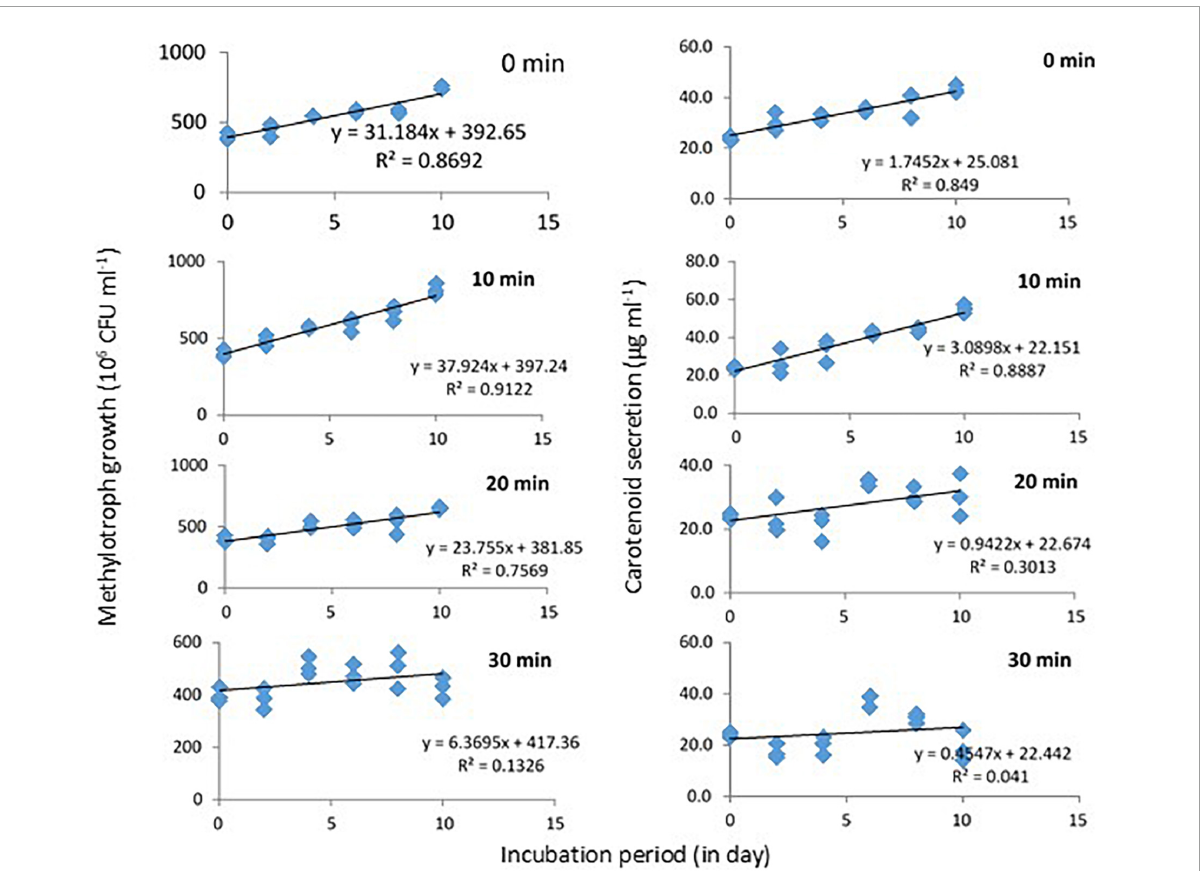
FIGURE4 Growth and carotenoid production by a pink pigmenting Methylobacter sp N39 (Genbank Acc no MW276130.1) in response to UV radiation. The bacterium was cultured in a synthetic medium. Broth was exposed to UV radiation for different timings (0, 10, 20, and 30 min). For each data point, a portion of broth was sampled at 2 days interval and used for estimating cell abundance and carotenoid concentration. Rest of the broth was exposed to UV radiation and incubated till next sampling. X -axis represents the incubation period, while Y -axis represents cell abundance (left panel) and carotenoid concentration (right panel) . Values are presented in 4